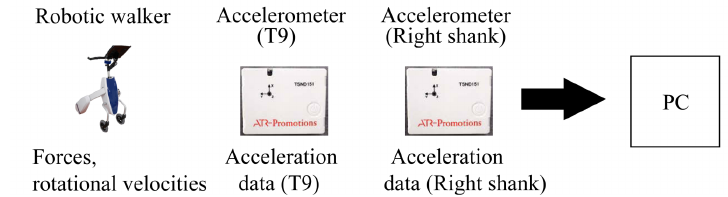
Figure 2. Data measurement process from the robotic walker and